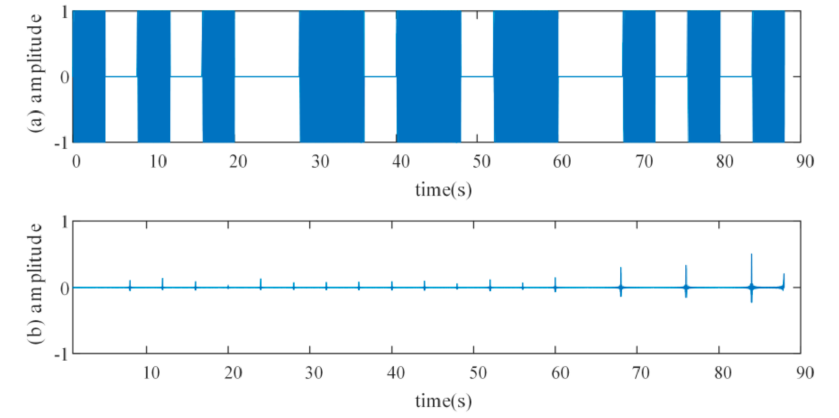
Figure 4. The direct cross-correlation in signal simulation; ( a ) The 200 Hz SOS signal in the simulation diagram; ( b ) The direct cross-correlation about SOS signal in the simulation